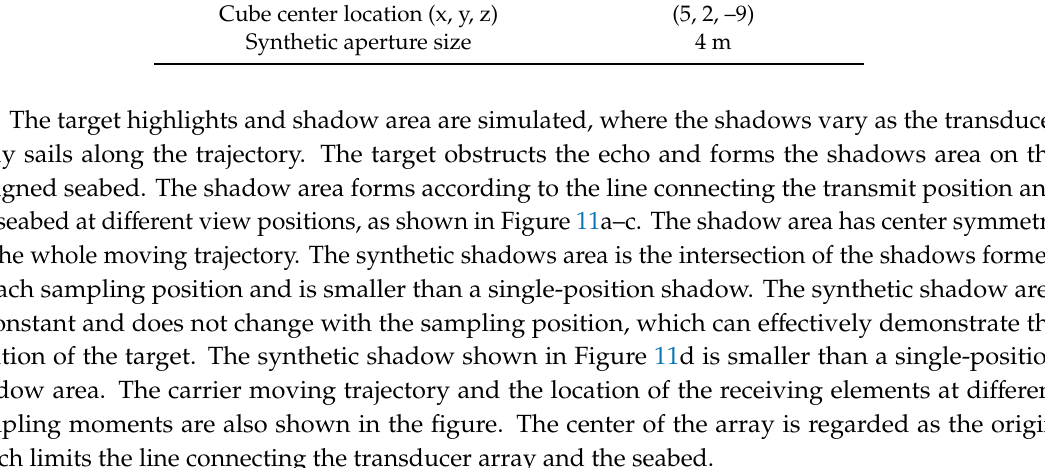
(b) Figure 12. Simulation of three adjusted targets: ( a ) imaging output of the targets; ( b ) perspective- sliced image from the bottom view. The sliced image is shown in Figure 12a. The adjusted targets can be separated after MBSAS image processing as marked. Then, the 3D image is sliced in the bottom view, which can indicate the shadows and the seabed in more detail. The targets in Figure 12b match the MBSAS imaging result. The seabed and shadows are the same as calculated in Equation (12). The cube bottom on the seabed